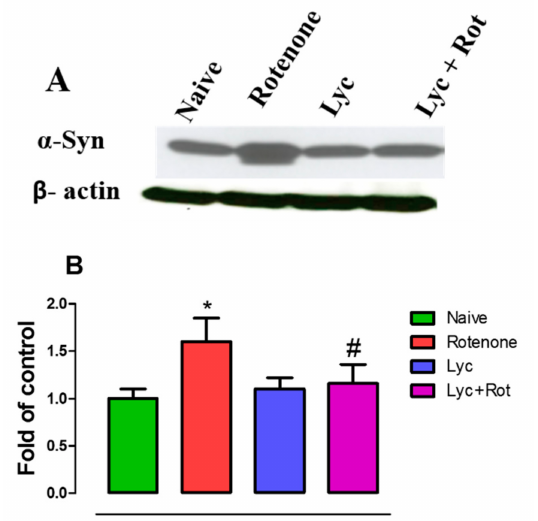
Figure 6. E ff ect of Lyc in alpha-synuclein expression in control and experimental animals. Lycopodium preventedrotenone-inducedalpha-synucleinexpression( A )inexperimentalanimals. Proteinexpression were quantified and represented ( B ) as fold of control. Values are expressed as mean ± SEM. * p < 0.05 compared to control, # p < 0.05 compared to the rotenone-treated